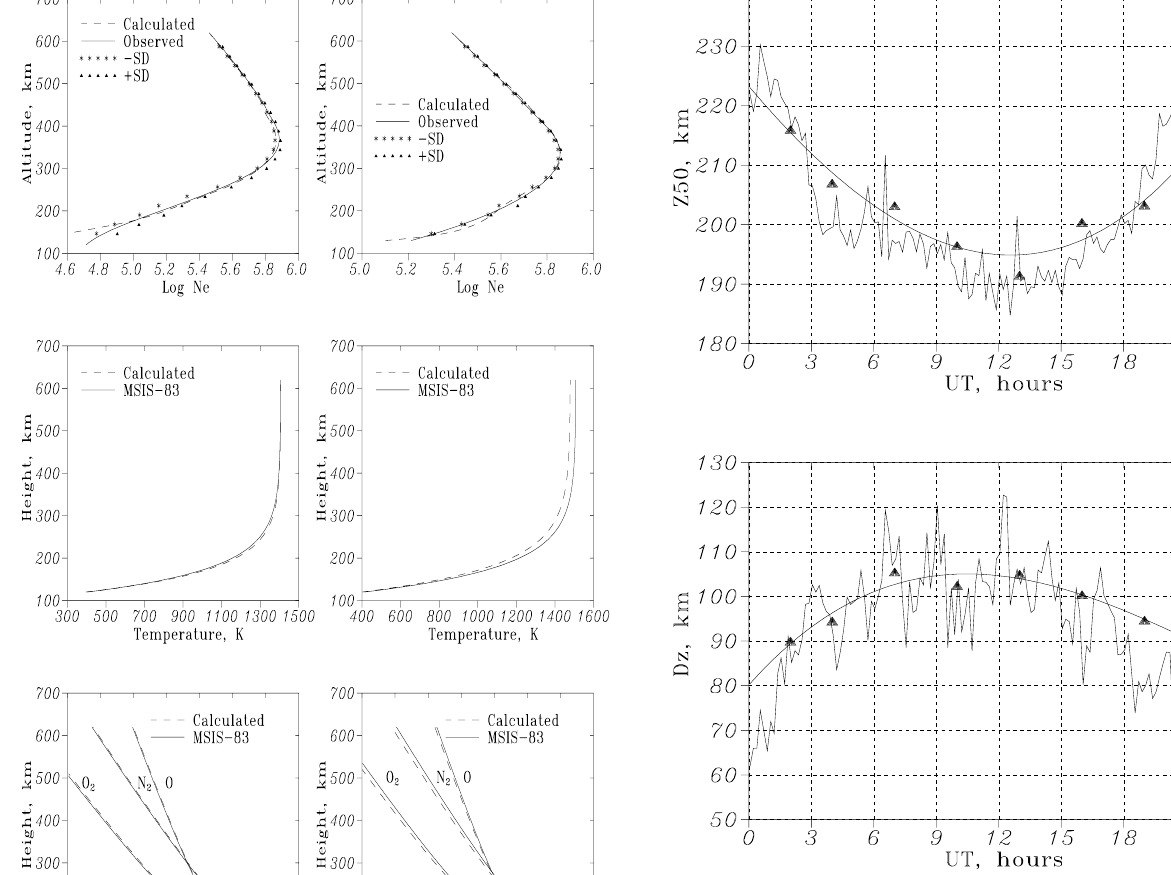
Fig. 3. Calculated (triangles) and experimental from Litvine et al. (1998) Z 50 and D z diurnal variations. A smooth curve is the least squares approximation of the calculated (triangles)